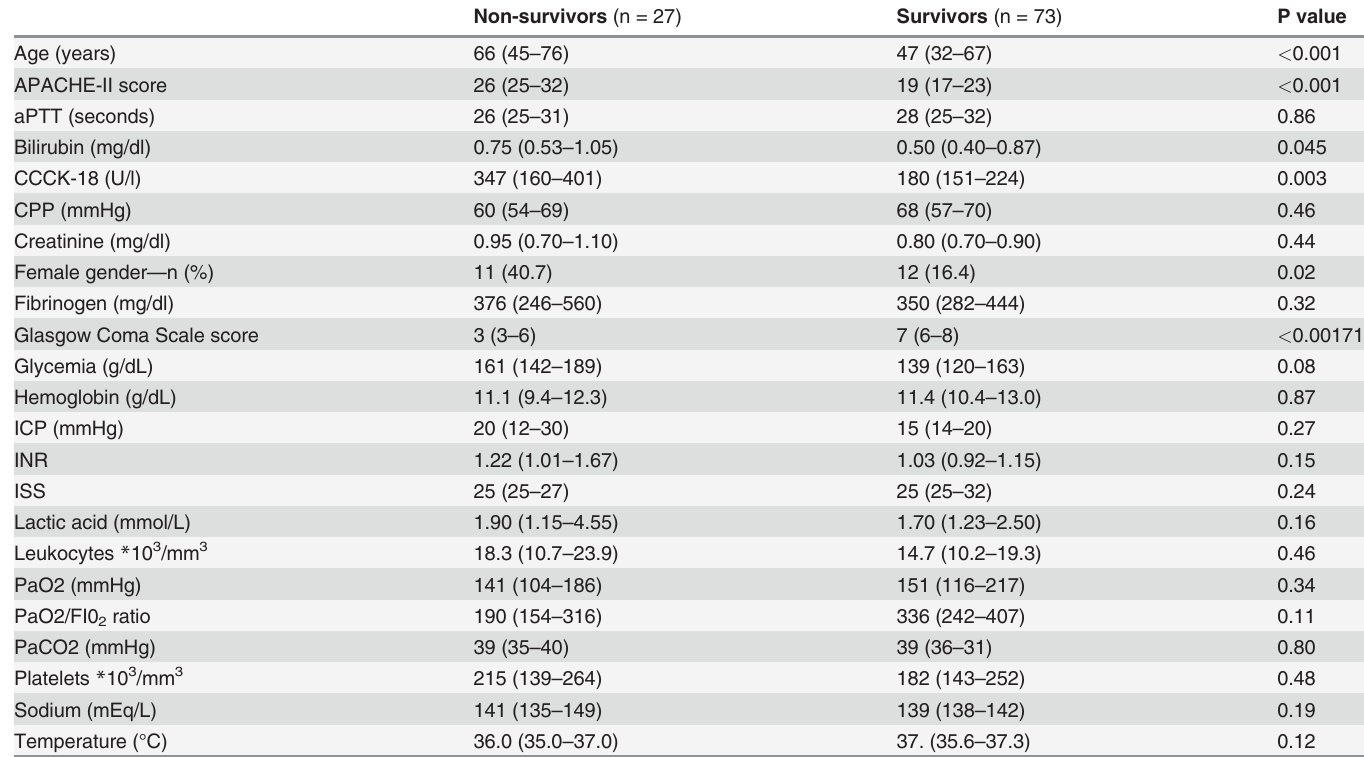
Table 2. Comparison of clinical and biochemical characteristics between non-surviving and surviving patients with traumatic brain